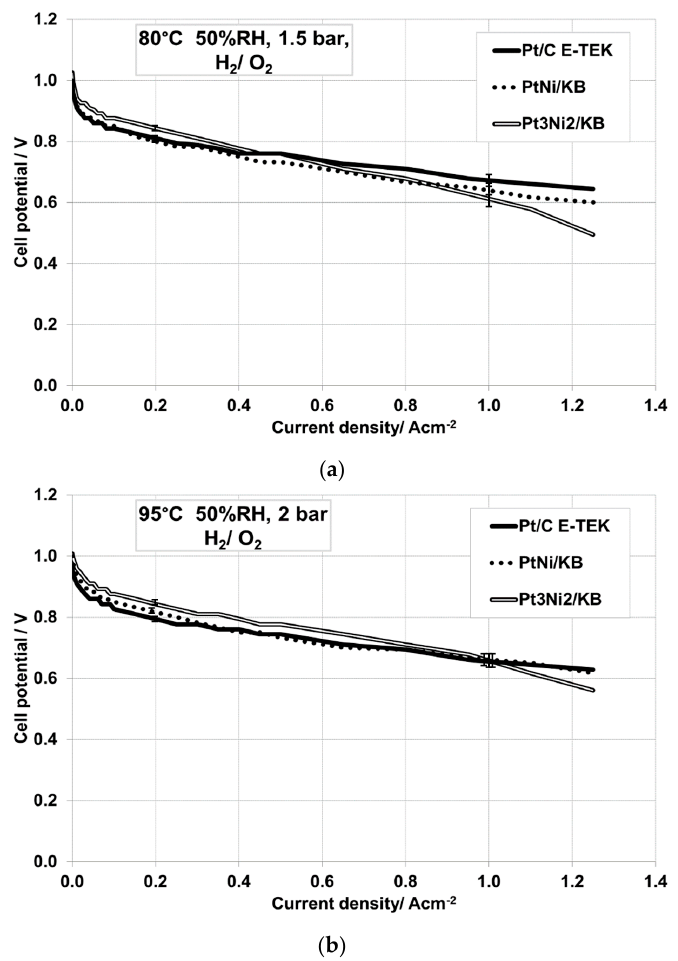
Figure 5. Polarization curves among the MEAs equipped with the different cathodic PtNi catalysts and the benchmark Pt/C catalyst at different operative conditions: ( a ) 80 °C, 50% R.H., 1.5 bar abs , H 2 /O 2 ; and ( b ) 95 °C, 50% R.H., 2 bar abs , H 2 /O 2 .